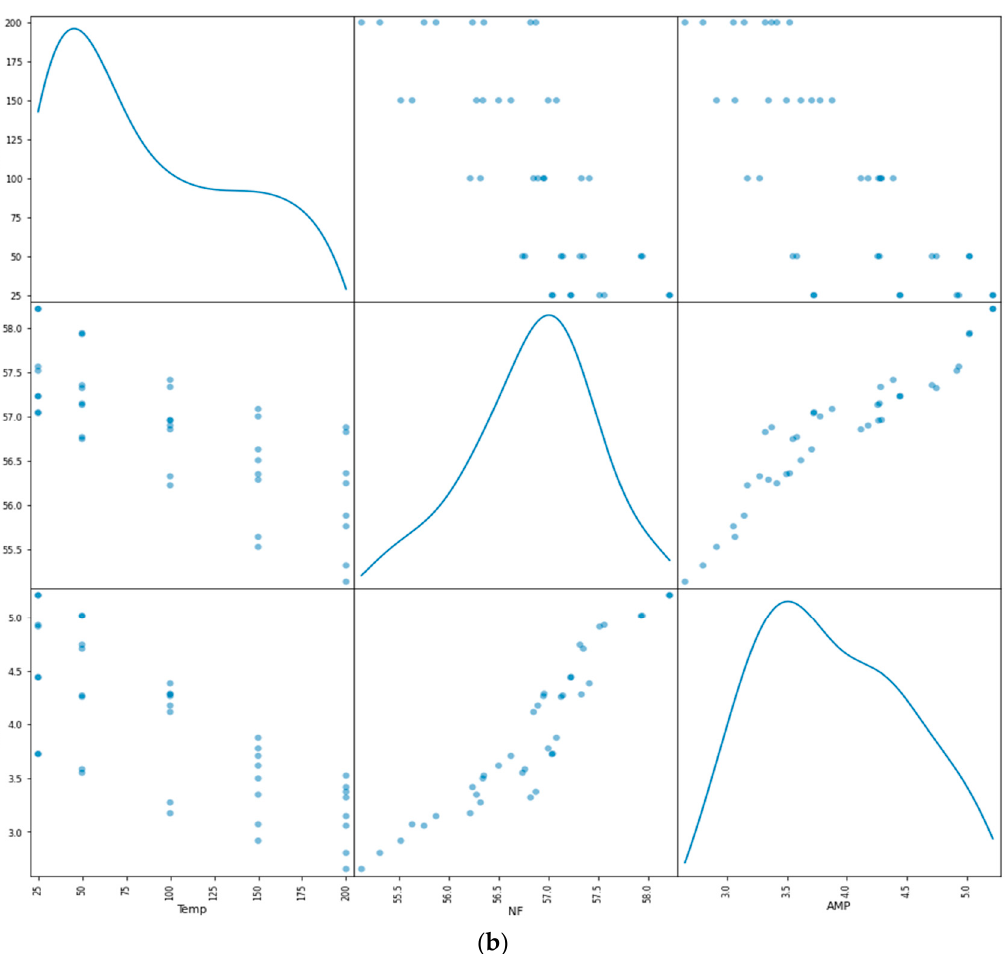
Figure 9. Scatter matrix for the relationship between the feature and the target variables of ( a ) polymer data ( b ) aluminum 2024-T3 data.